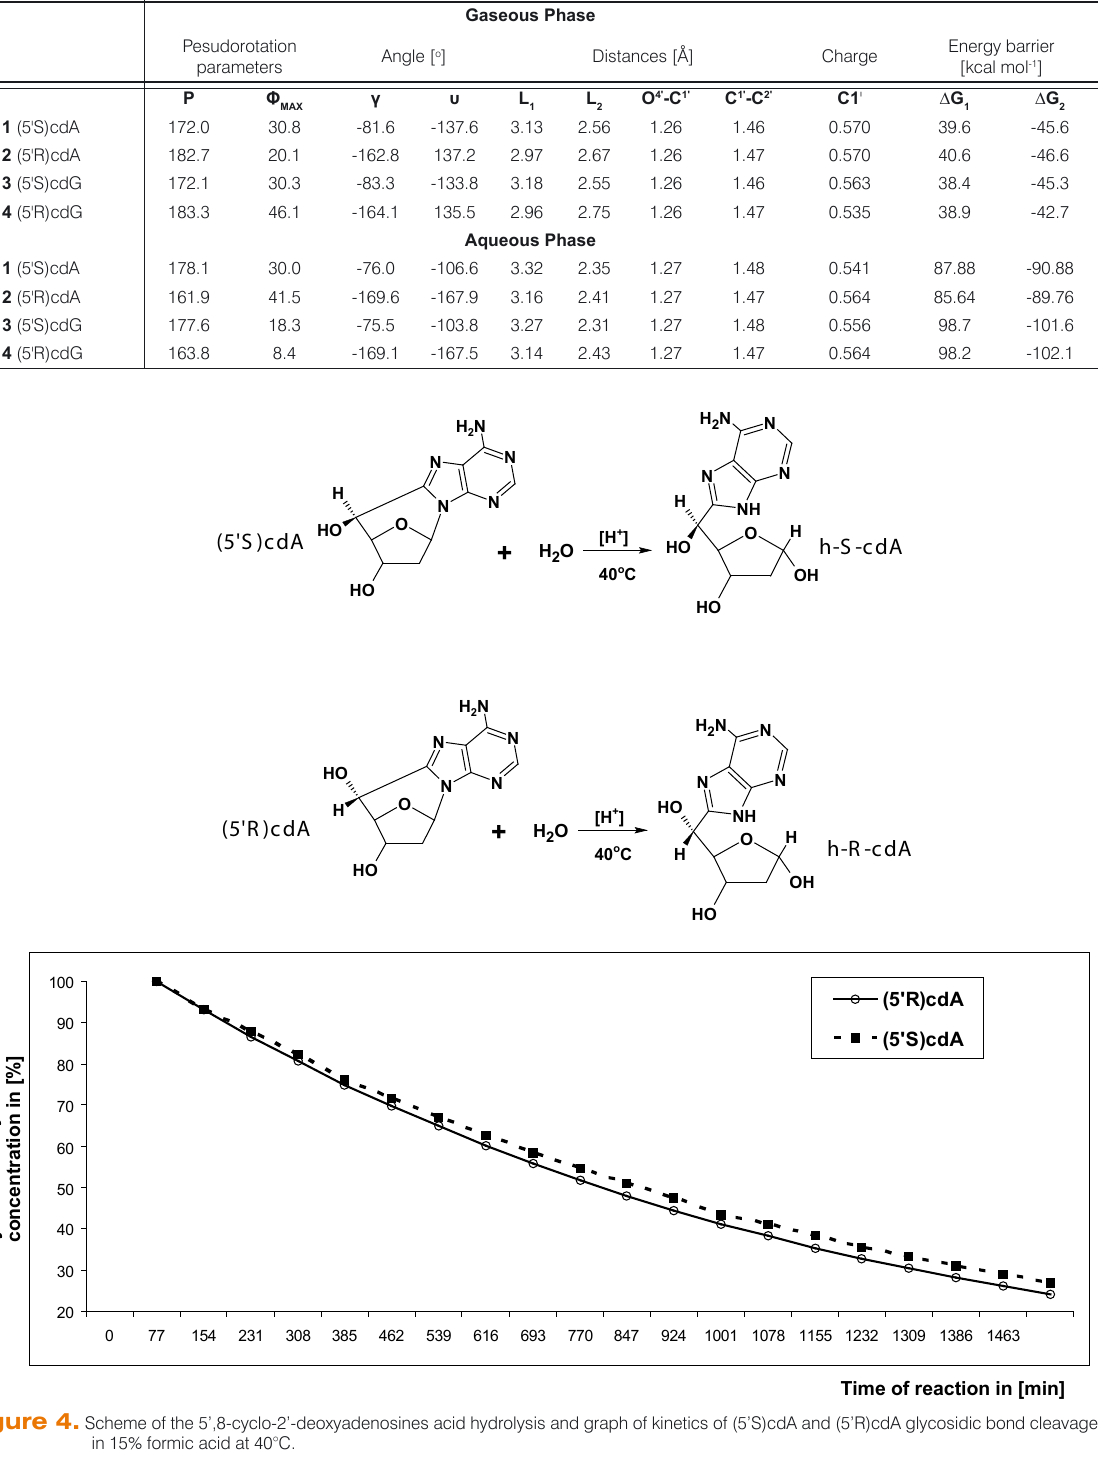
Figure 4. Scheme of the 5’,8-cyclo-2’-deoxyadenosines acid hydrolysis and graph of kinetics of (5’S)cdA and (5’R)cdA glycosidic bond cleavage in 15% formic acid at